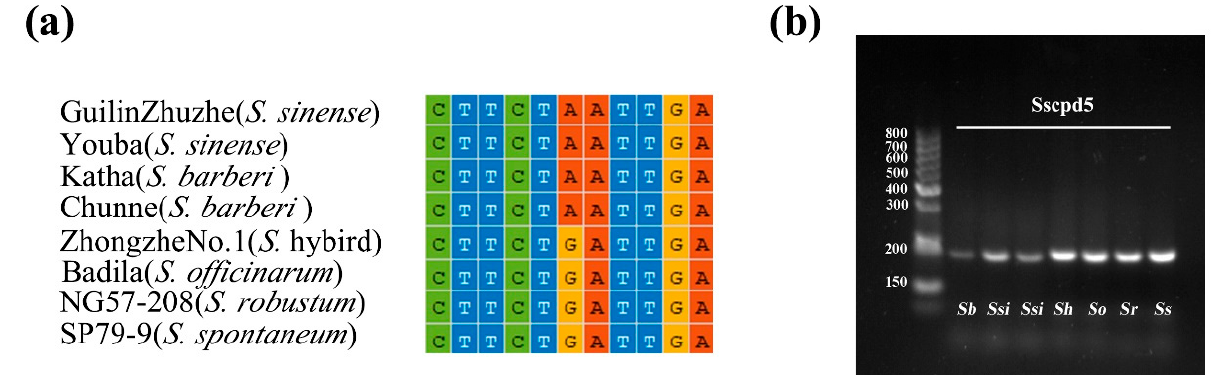
Table 4. dCAPS maker design based on SNPs between S. sinense/S. barberi and other Saccharum spe- cies.